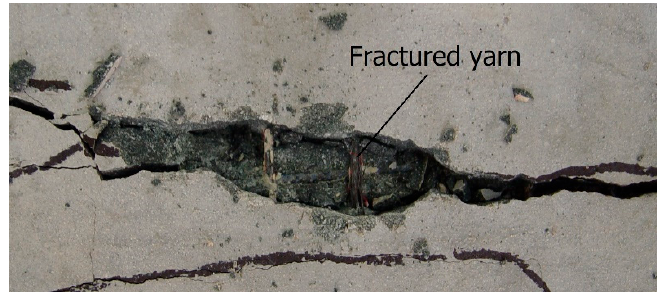
Figure 12. Fracture of textile at the mid-span of S15-1 specimen.